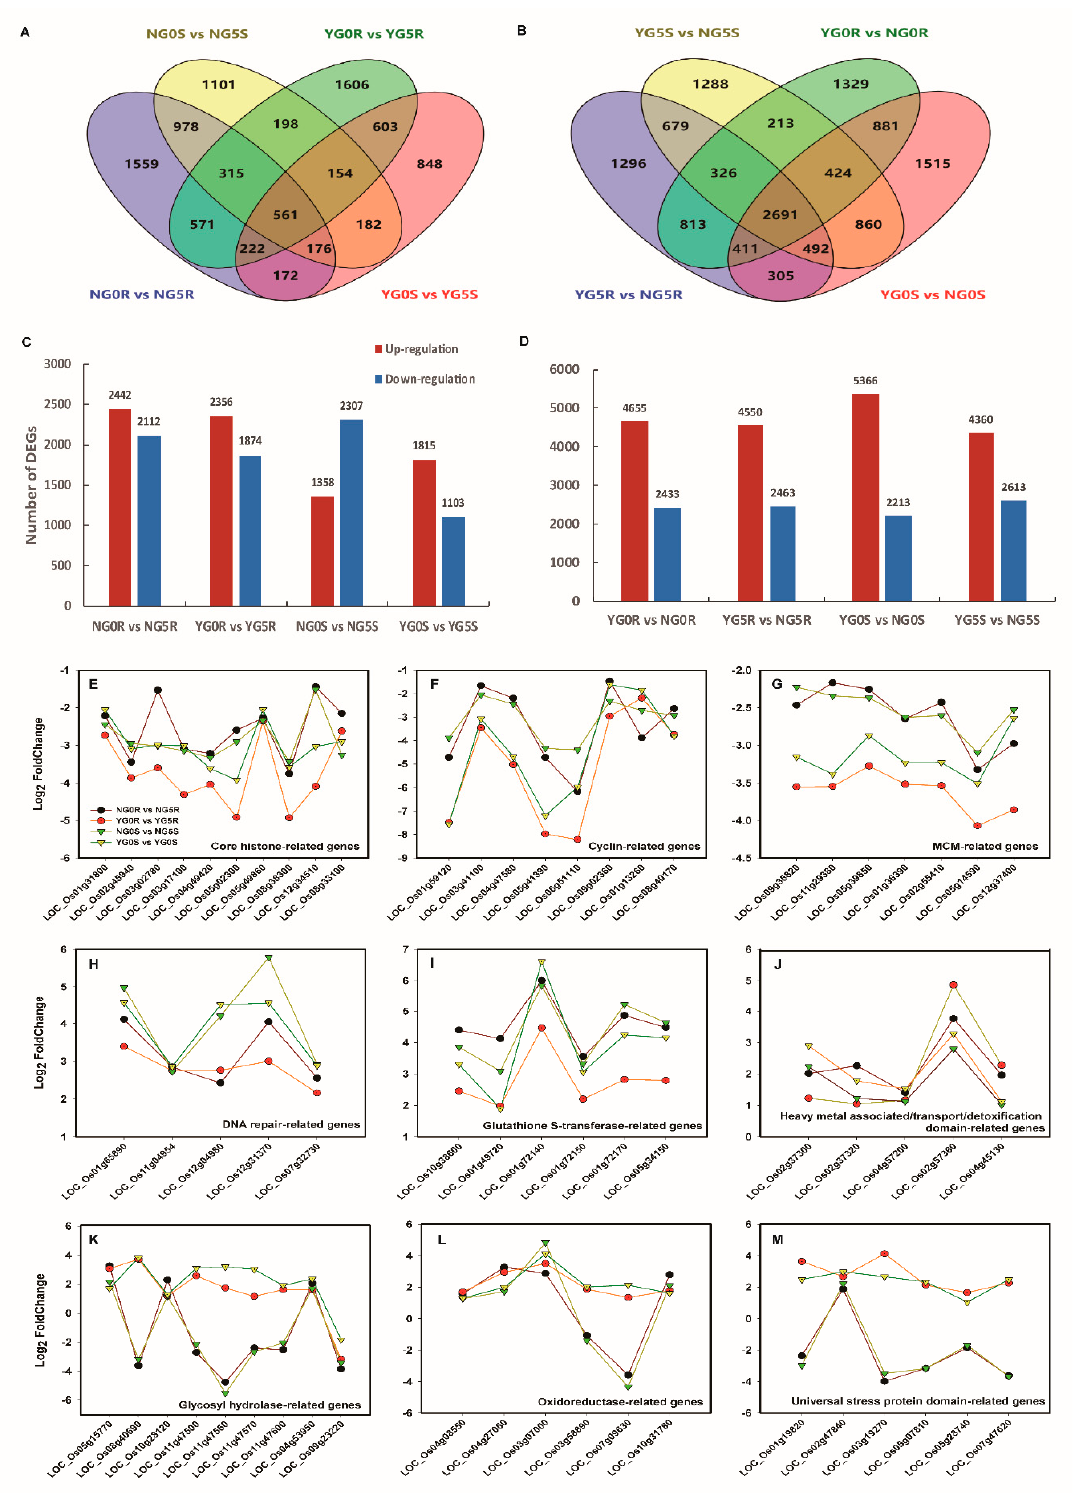
Figure 5. Di ff erences of global gene expression profiling in shoot and root of NPB and YD6 under irradiation. ( A , B ) Venn diagrams of di ff erentially expressed genes (DEGs) between irradiation response ( A ) and varietal e ff ect ( B ); ( C , D ) Numbers of DEGs in each comparison between irradiation response ( C ) and varietal e ff ect ( D ); ( E – M ) Changes of some DEGs associated with core histone ( E ), cyclin ( F ), MCM ( G ), DNA-repair ( H ), glutathione S-transferase ( I ), heavy metal associated / transport / detoxification ( J ), glycosyl hydrolase ( K ), oxidoreductase ( L ) and universal stress protein ( M ) in response to